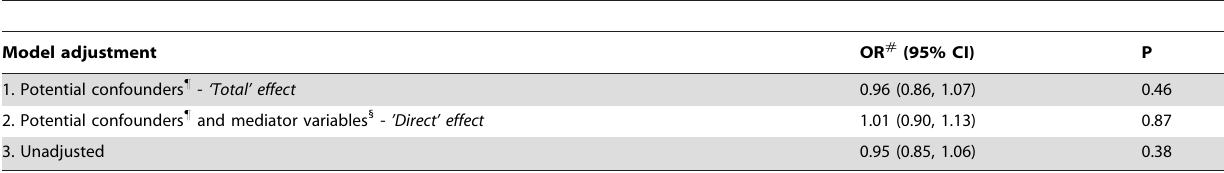
Table 1. Severity-adjusted * average relative effect of vitamin D concentration across 11 cardiac morbidities among 426 cardiac surgical patients.